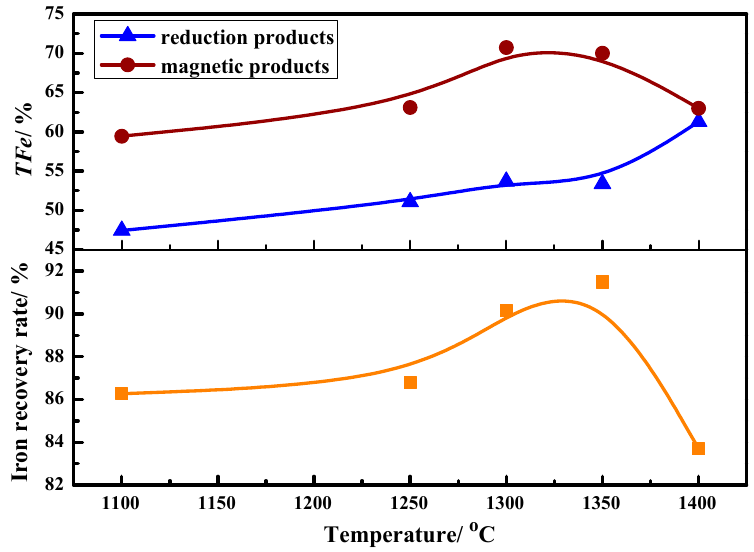
Figure 9. The grade of the reduced products and magnetic products and iron recovery rate at different temperatures. different temperatures. Table 3. Chemical compositions of reduced LGVTMP at 1350 °C and the corresponding magnetic Table 3. Chemical compositions of reduced LGVTMP at 1350 ◦ C and the corresponding magnetic and and non-magnetic products after magnetic separation (wt %). non-magnetic products after magnetic separation (wt